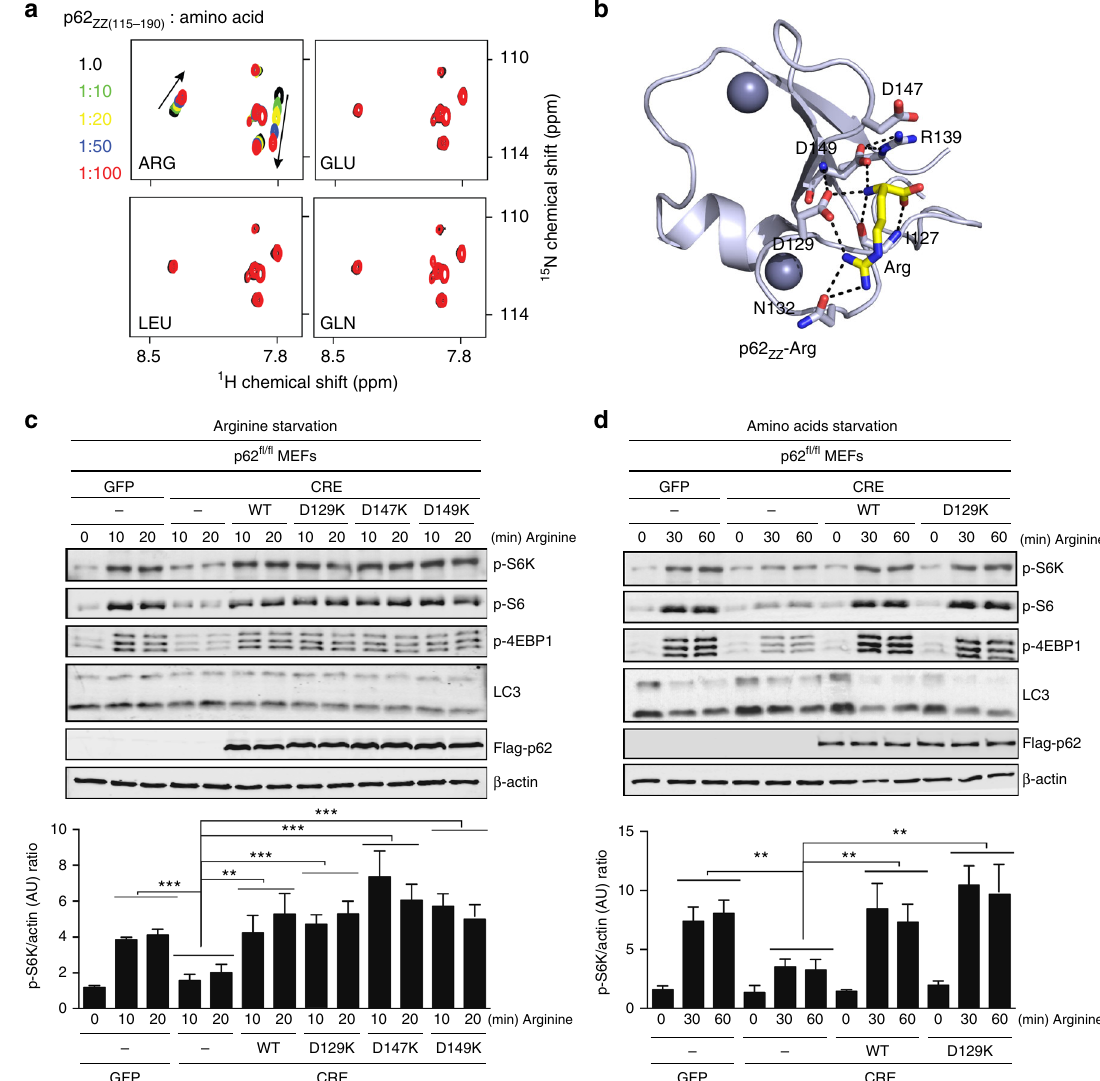
Fig. 5 p62 is not a direct arginine sensor in mTORC1 pathway. a Superimposed 1 H, 15 N HSQC spectra of p62 ZZ (115 – 190) collected upon titration with the indicated free amino acids. Spectra are color coded according to the protein:ligand molar ratio. b A ribbon diagram of the crystal structure of p62 ZZ (wheat) in complex with the amino-acid arginine (yellow). c Mouse p62 fl / fl embryonic fi broblasts infected with GFP or CRE adenoviruses were reconstituted with retroviruses expressing Flag-p62 WT, D129K, D147K, or D149K. Cells were deprived of arginine for 4 h and then stimulated with arginine for the indicated durations. Cell lysates were analyzed for the levels of the speci fi ed proteins. Graphs represent p-S6K/actin ratio as measured by densitometry using Image studio software ( n = 3 independent experiments). d p62 fl / fl MEFs cells infected with GFP or CRE adenoviruses and stably expressing Flag-p62 WT or D129K, were deprived of amino acids for 4 h and then stimulated with arginine for the indicated durations. Cell lysates were analyzed for the levels of the speci fi ed proteins. Graphs represent p-S6K/actin ratio as measured by densitometry using Image studio software ( n = 3 independent experiments). Two- way ANOVA test ** p < 0.01, *** p < 0.001. Error bar in c and d represents s.e.m. with N of